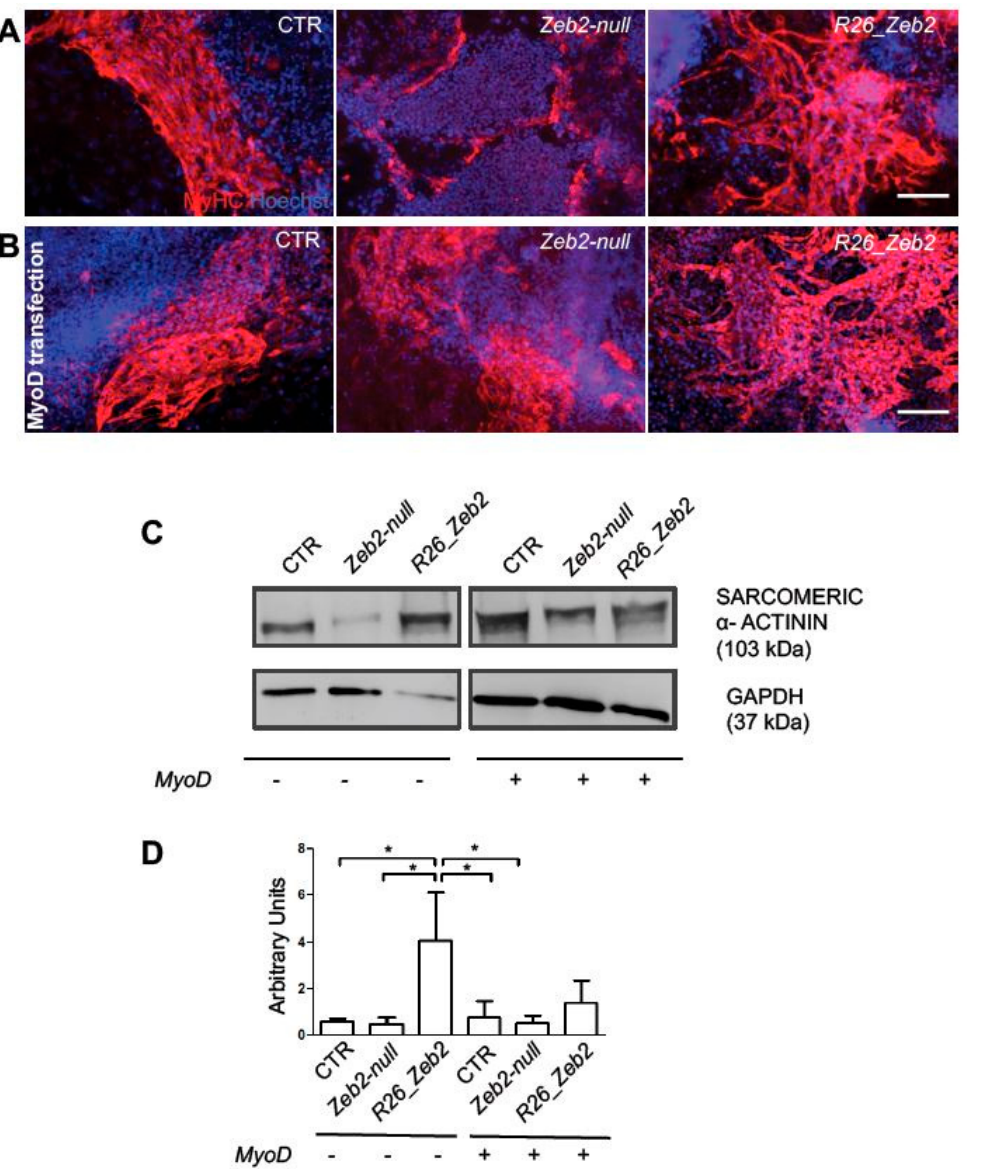
Figure 2. Protein localization and quantification of myogenic markers in Zeb2-null and R26_Zeb2 mESCs subjected to myogenic differentiation. Immunofluorescence analysis for MyHC (red) after 22 days from myogenic induction ( A ) or upon MyoD transfection ( B ). The nuclei were stained in blue with Hoechst. Scale bars = 50 µm. ( C ) Example of WB analysis for sarcomeric α -actinin and GAPDH on day 22 from myogenic induction or upon MyoD transfection. ( D ) The quantification of WB analysis showed in C and normalized by the GAPDH housekeeping. Values are shown as mean ± SD; n = 3, * p < 0.05.